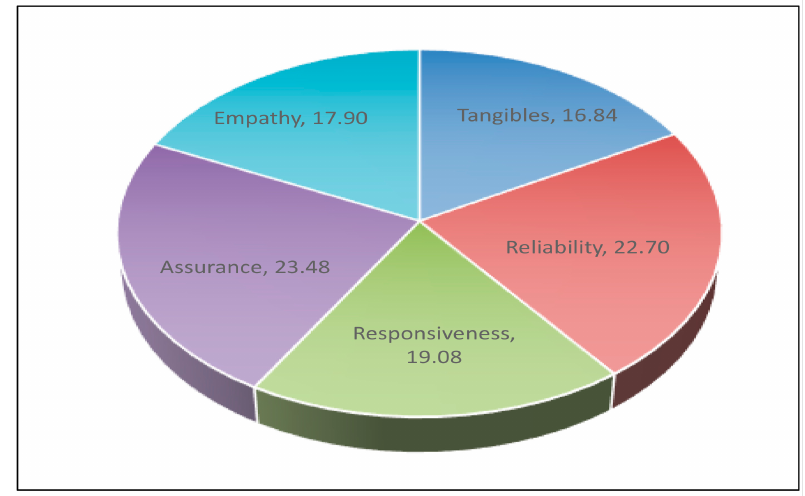
Figure 1. Prioritization of quality